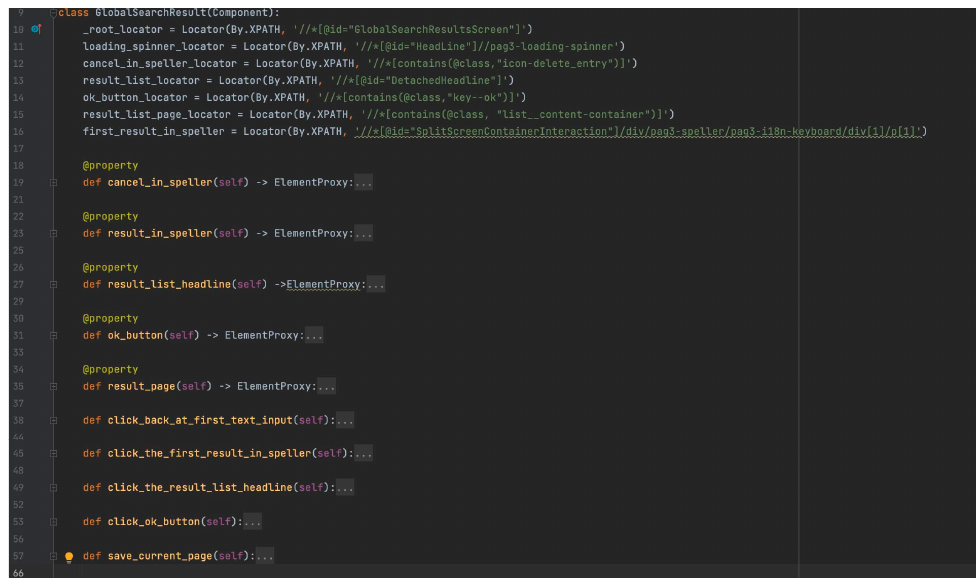
Figure 18. Example of a page class definition using POM.